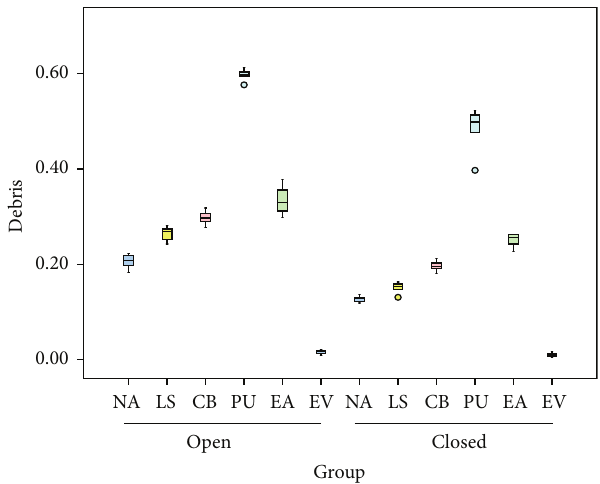
Figure 1: Box diagram showing amount of debris extruded in grams in each groups. Data are presented as mean and standard